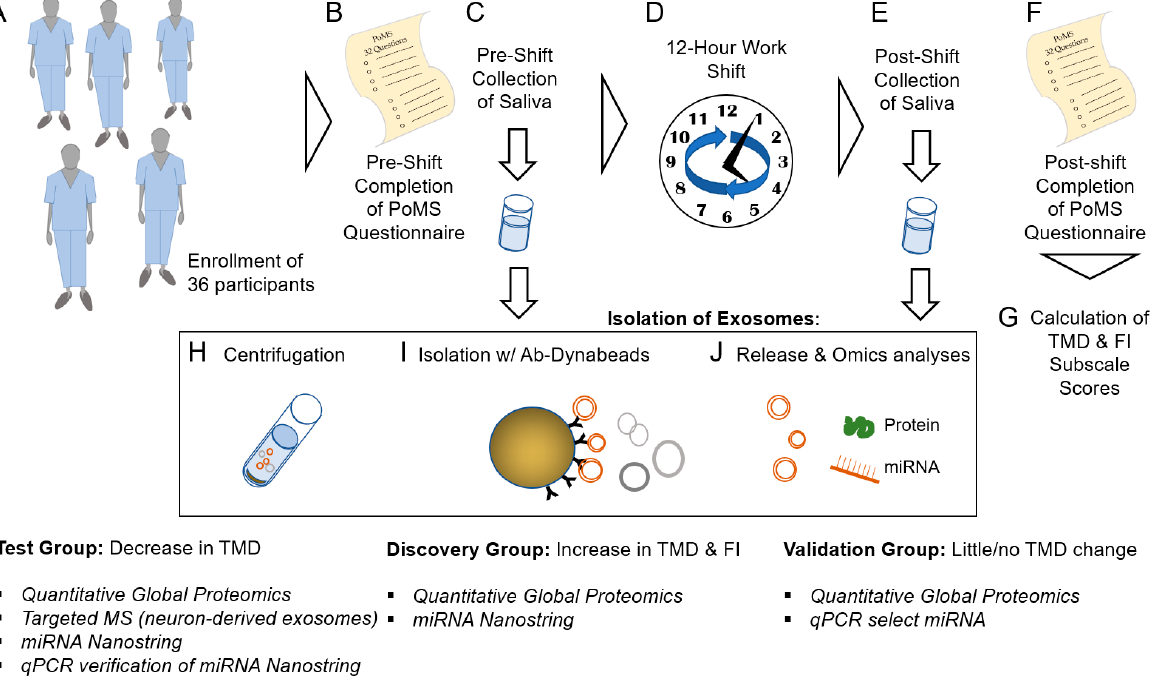
Figure 6. Study flow scheme for Profile of Mood States (PoMS) assessment, sample collection, pro- cessing, and analysis. ( A ) Resident participants ( n = 36) were enrolled. ( B ) Participants completed the PoMS questionnaire and ( C ) collected saliva before a ( D ) 12 h work shift. ( E ) Saliva was collected, and the ( F ) PoMS questionnaire completed again after the work shift. ( G ) Total Mood Disturbance (TMD) and subscale (for example, fatigue–inertia, FI) scores were calculated. Isolation of exosomes comprised ( H ) centrifugation, ( I ) binding of exosomes to exosome marker-specific (and in one instance, neuronal-marker specific) antibody-conjugated Dynabeads, ( J ) release of exosomes for processing, and omics analyses. Based on TMD, participant samples were separated into Test (decrease in TMD or ‘improved’ mood), Discovery (increased in TMD or mood disturbance), and Validation (little/no change in TMD) groups. Exosomes from each group underwent the anal- yses shown.